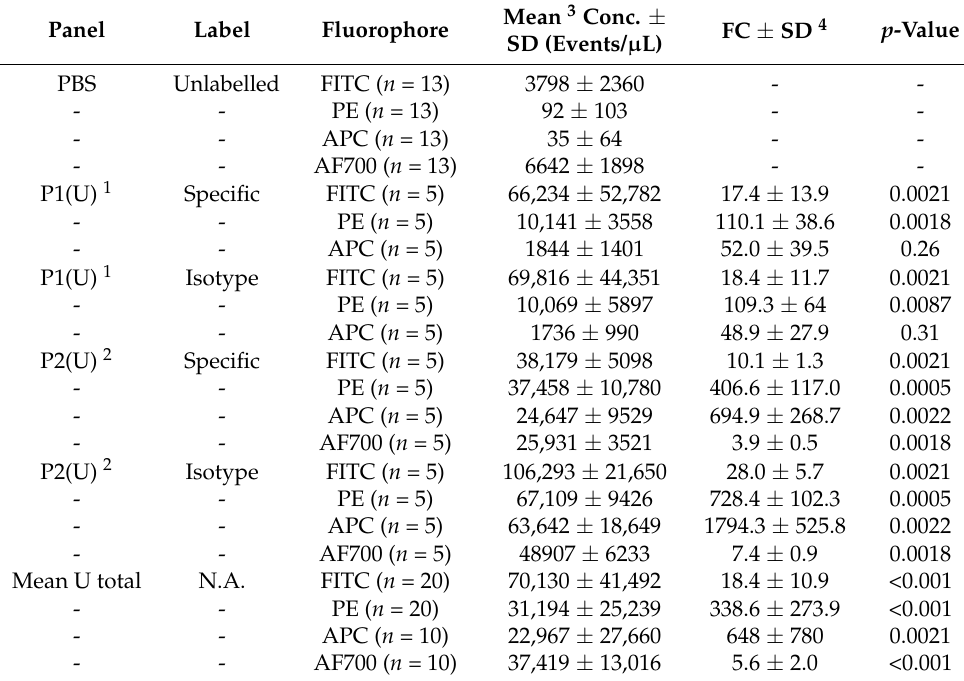
Table 3. Concentration of fluorophores in PBS labeled with untreated panels, compared to unlabelled